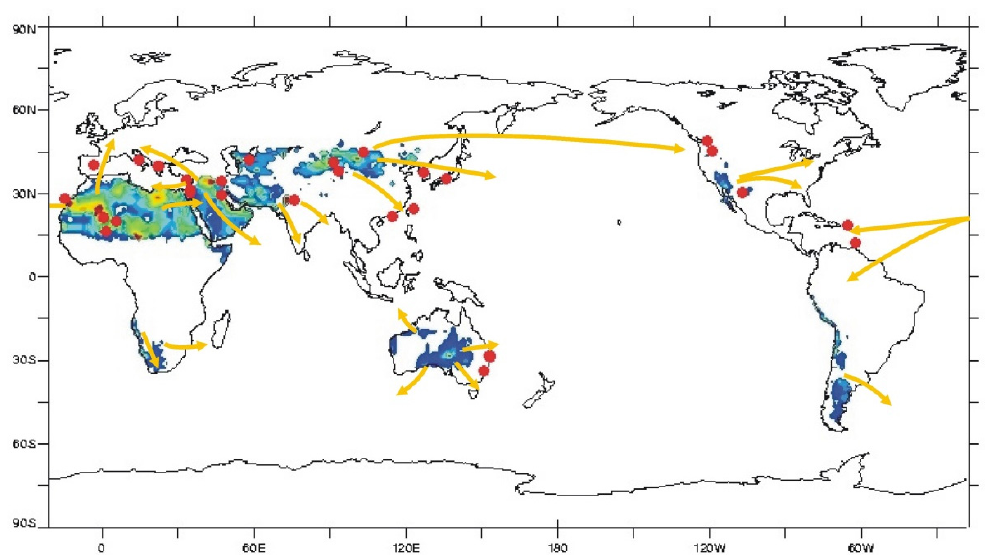
Figure 1. The geographical distribution of the linkage between dust sources and epidemical study areas (red points: locations of reported effects of desert dust on human health; color-filled contour: distribution of dust sources).